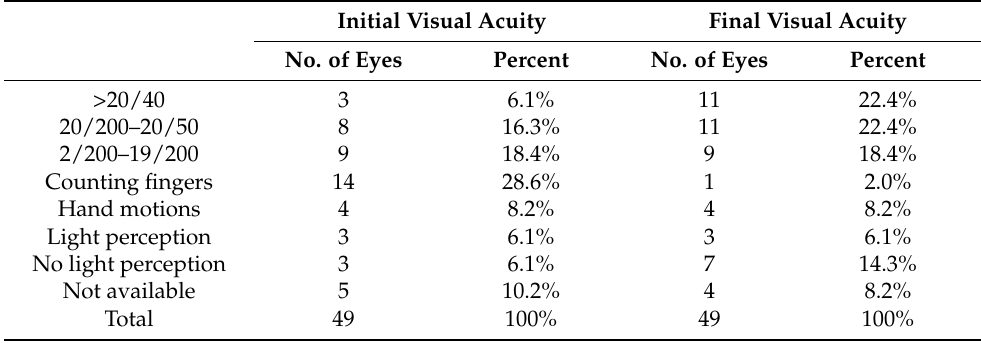
Table 5. Visual outcomes of eyes with endogenous fungal